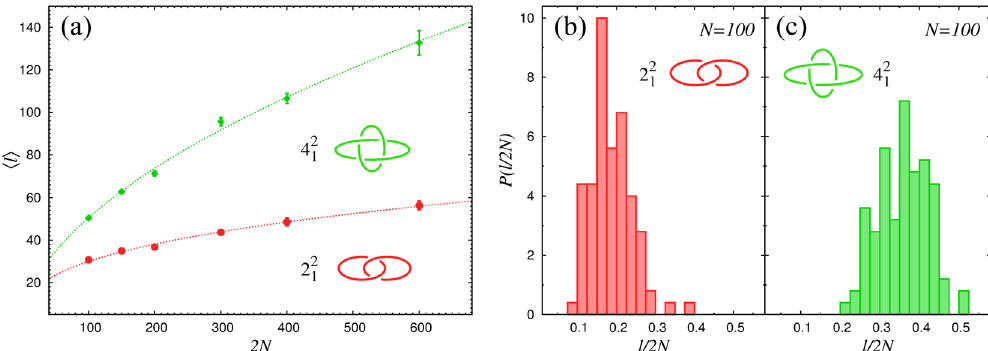
Figure 4. Scaling and statistical properties of linked portions: ( a ) Average contour length of the linked portions,  , as a function of the total contour length 2 N , for Hopf (red circles) and Solomon (green diamonds) links formed by semi-flexible rings each of N = 100 beads. For each set of data the solid curve corresponds to power law fits (see Eq. 1). Panels (b) and (c) Probability distribution of the fraction of contour length in the linked portion,  N /2 , for Hopf ( b ) and Solomon ( c )